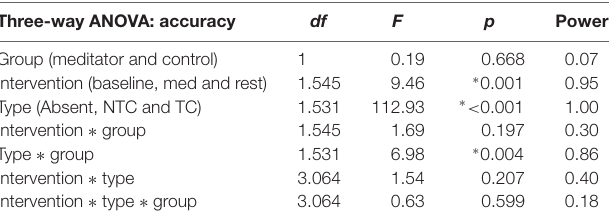
TABLE 2 | Results of analysis of variance (ANOVA) of accuracy data.